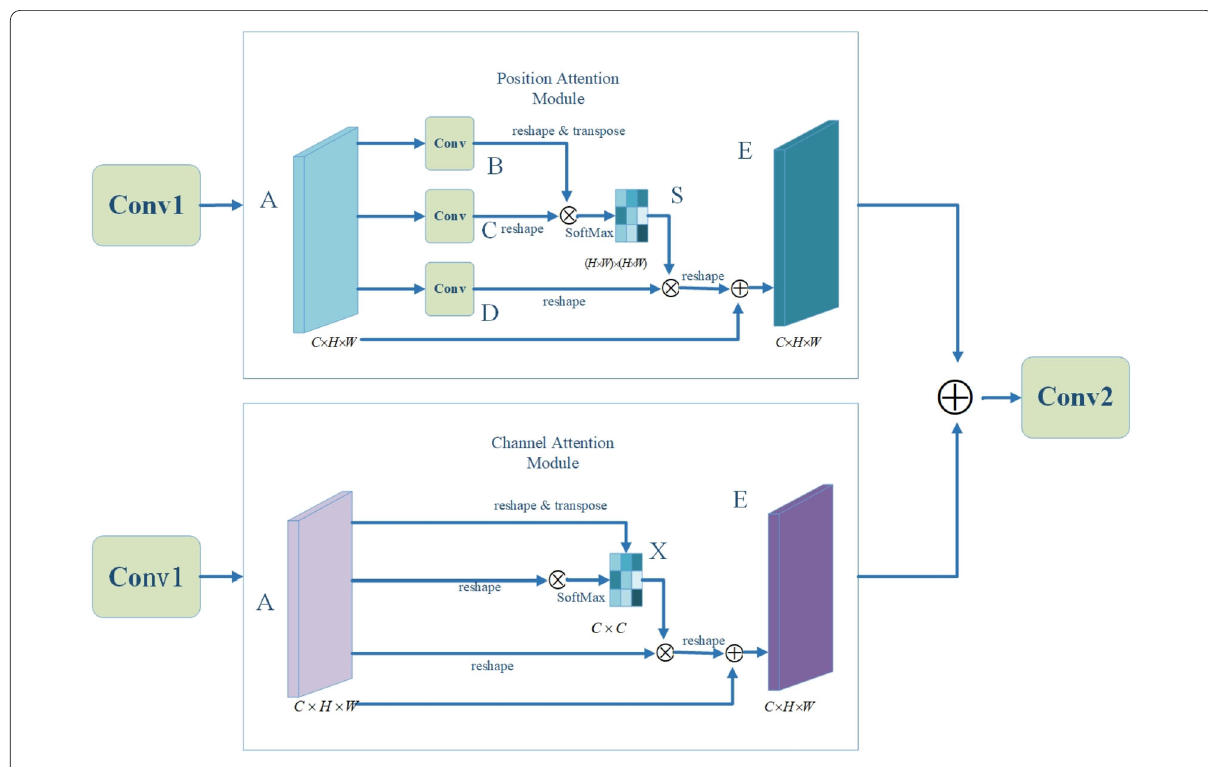
Figure 4 The structure of the Dual Attention